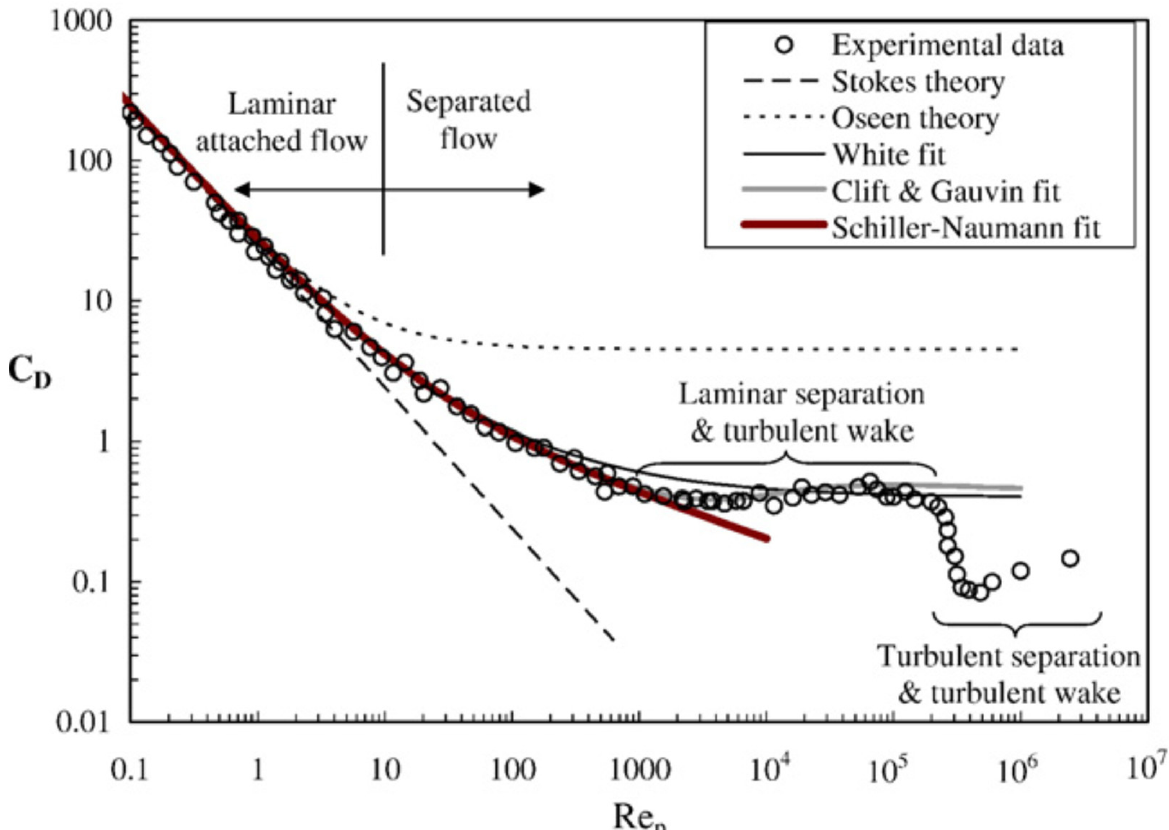
Figure 1. Drag coefficient for a smooth solid sphere at various Reynolds numbers for incompressible Reprinted from [8] with permission from Elsevier.